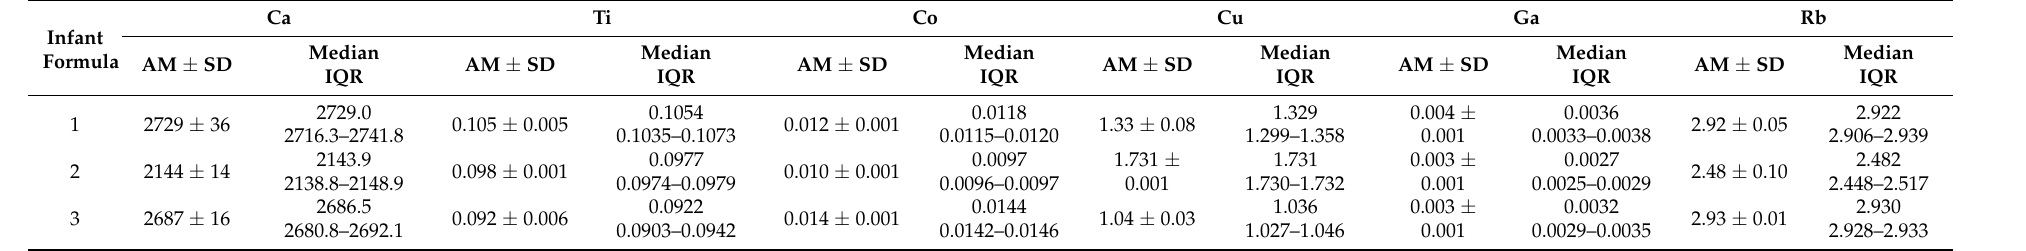
Table 3. Descriptive statistics of Ca, Ti, Co, Cu, Ga and Rb calculated on a total of 12 determinations for each formula and expressed as µ g g − 1